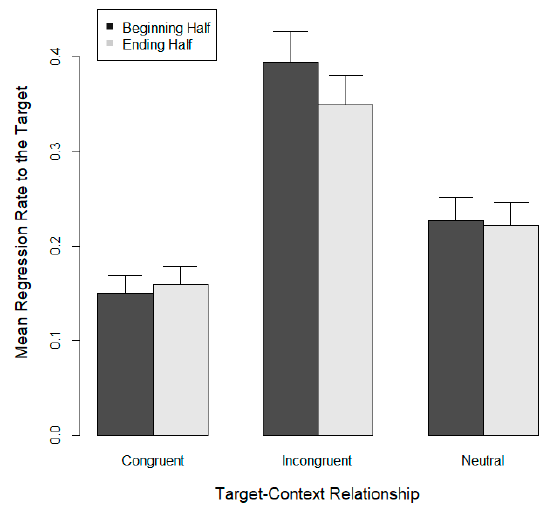
Figure 4. Mean regression rate to target words and standard errors as a function of targets’ consistency with subsequent sentence content. Incongruent target words were replaced with congruent targets when readers regressed back to the target.